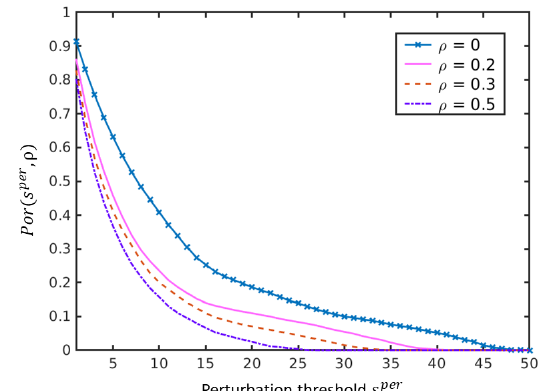
Figure 10. The effect of erroneous labels on perturbation thresholds of NCCs estimated empirically on the Salinas Scene data set. The portion of samples whose perturbation threshold is above a given value s ( per ) is plotted for different values of ρ and denoted by Por ( s ( per ) ; ρ ) . Observe that this portion Por ( s ( per ) ; ρ ) drops when ρ is larger indicating that with increasing the label noise the performance becomes less reliable on more and more